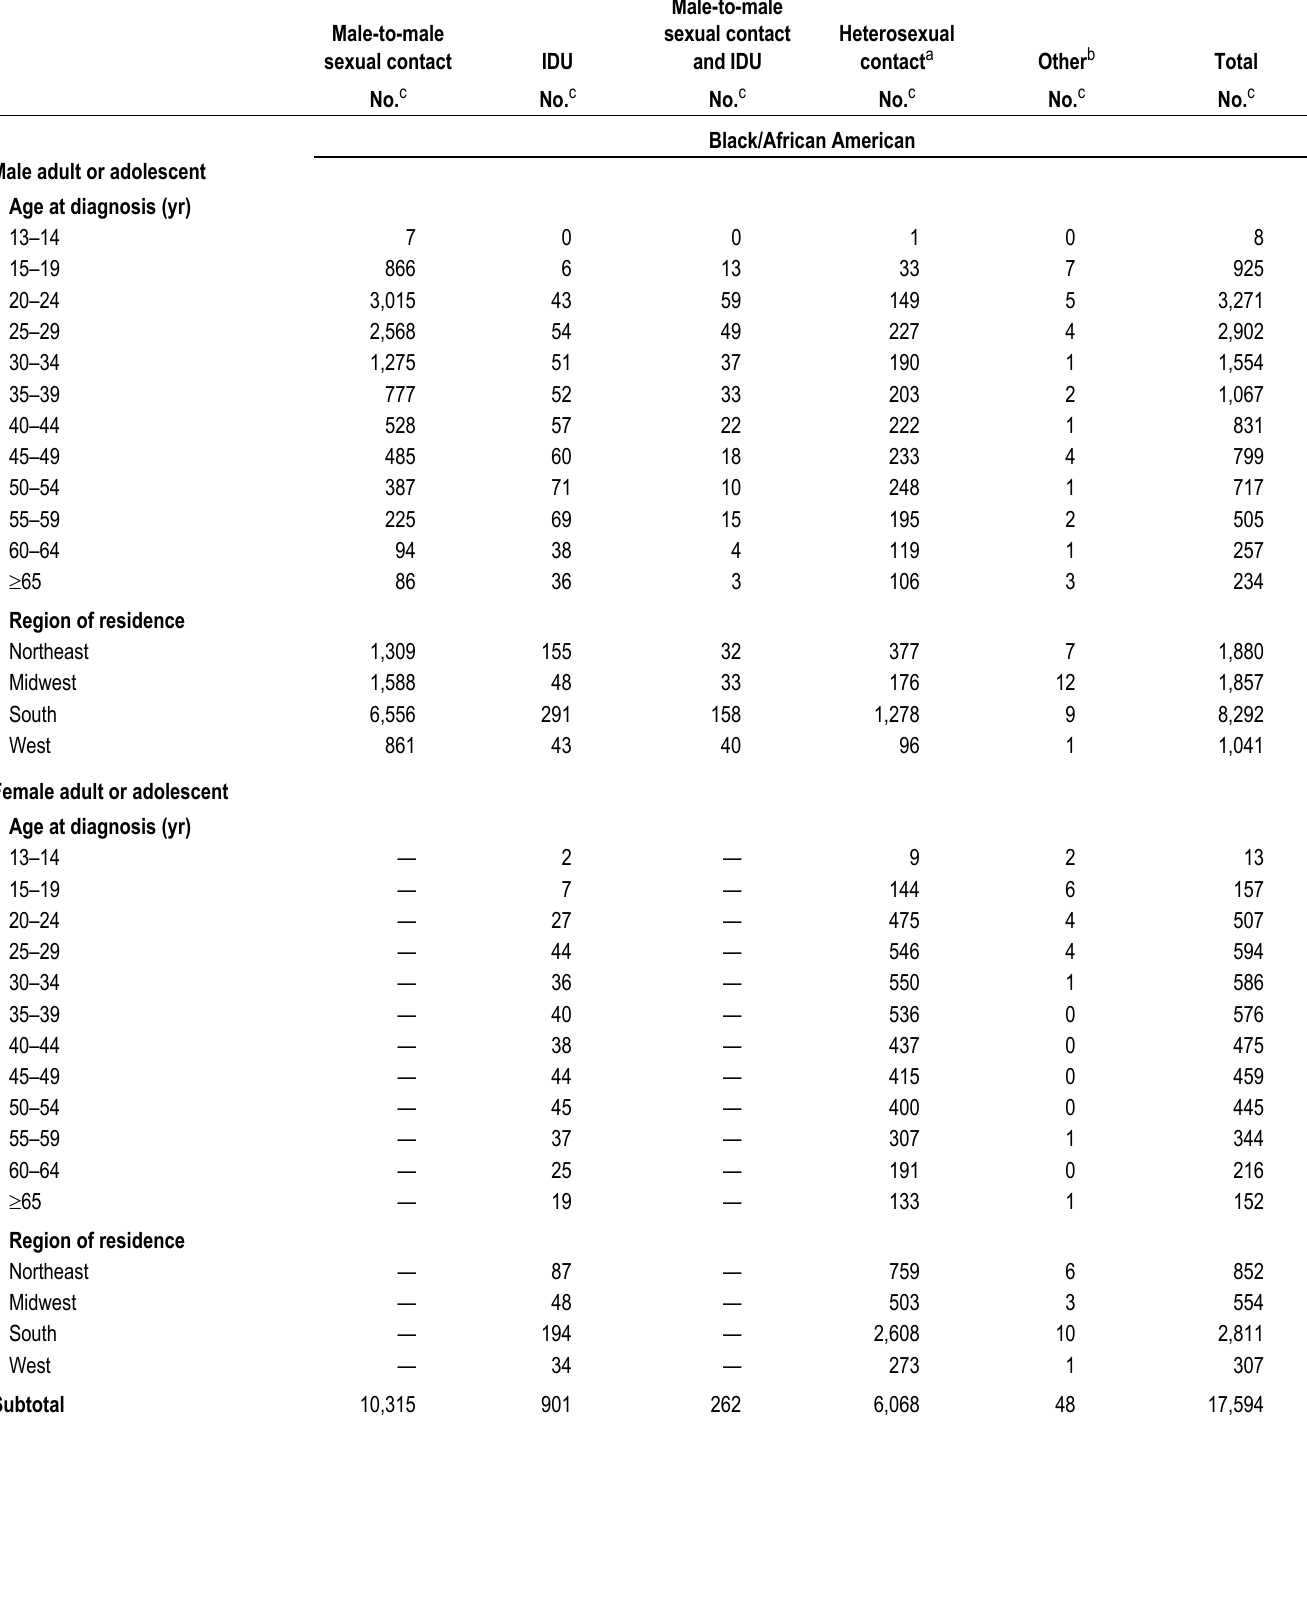
Table 5a. Diagnoses of HIV infection, by transmission category, race/ethnicity, and selected characteristics, 2015—United States